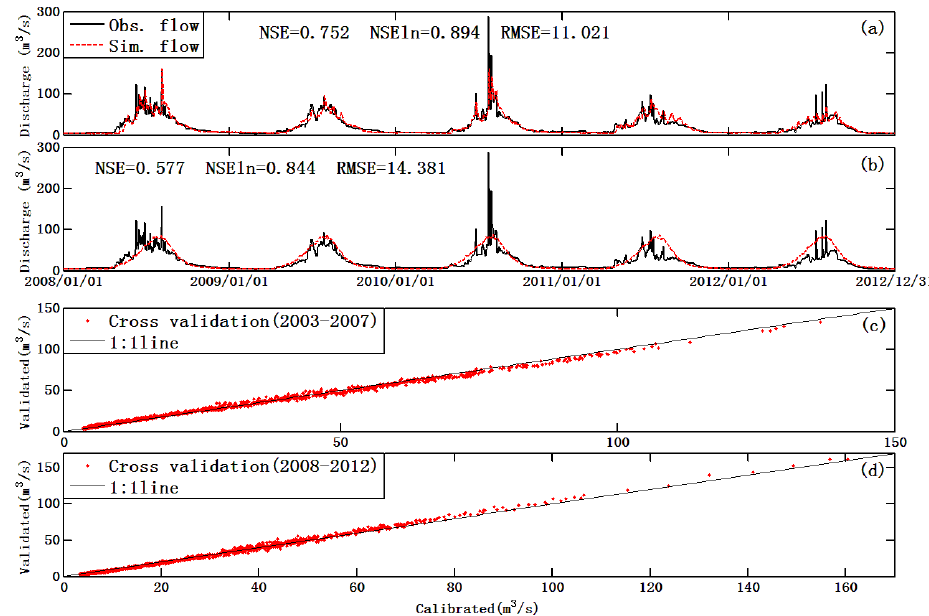
Figure 9. Evaluation of the stepwise calibration method. (a) discharge simulation in evaluation period 2008–2012 using the stepwise cali- brated parameters in calibration period 2003–2007. (b) discharge simulation in evaluation period 2008–2012 by the benchmark model. (c) Cross-validation simulation of daily discharge in 2003–2007. x coordinate presents the simulated daily discharges by parameters calibrated in the period 2003–2007. y coordinate presents the simulated daily discharges by parameters calibrated in the period 2008–2012. (d) Cross- validation simulation of daily discharge in 2008–2012. x coordinate presents the simulated daily discharges by parameters calibrated in the period 2008–2012. y coordinate presents the simulated daily discharges by parameters calibrated in the period